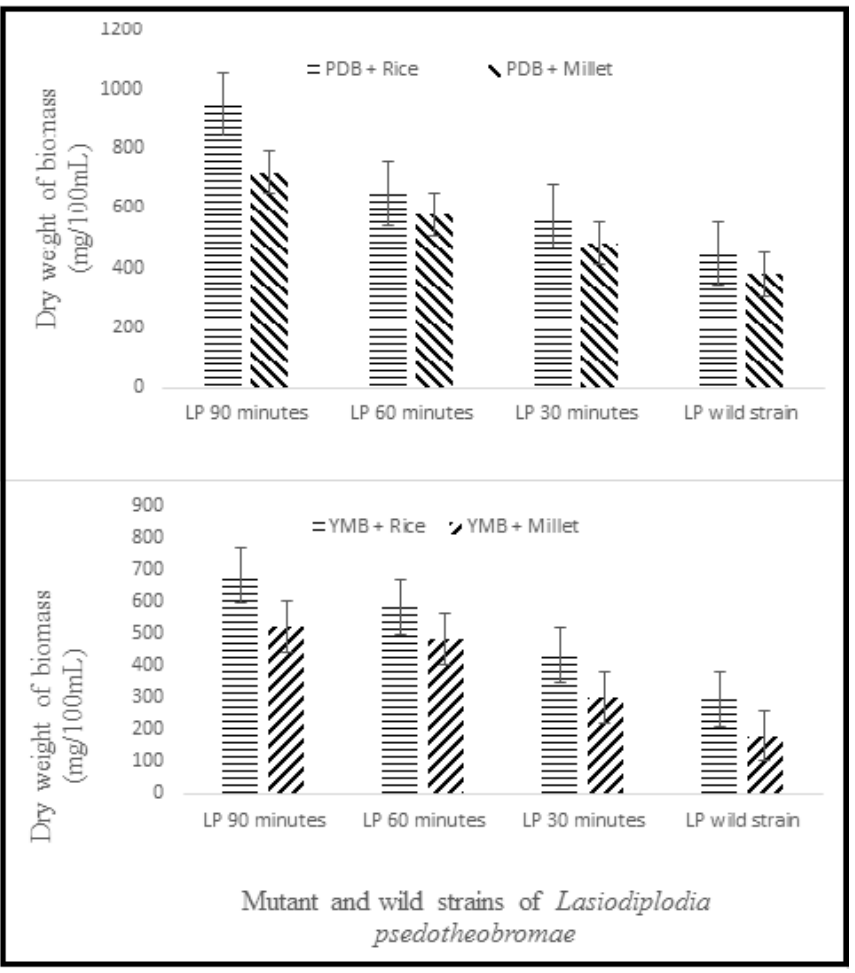
Fig. 1. Effect of biphasic system on biomass production from wild and mutant strains of C1136; (A) The dry weight biomass of strains C1136 produced from PDB + rice and PDB + millet; (B) The dry weight biomass of strains C1136 produced from YMB + rice and YMB +